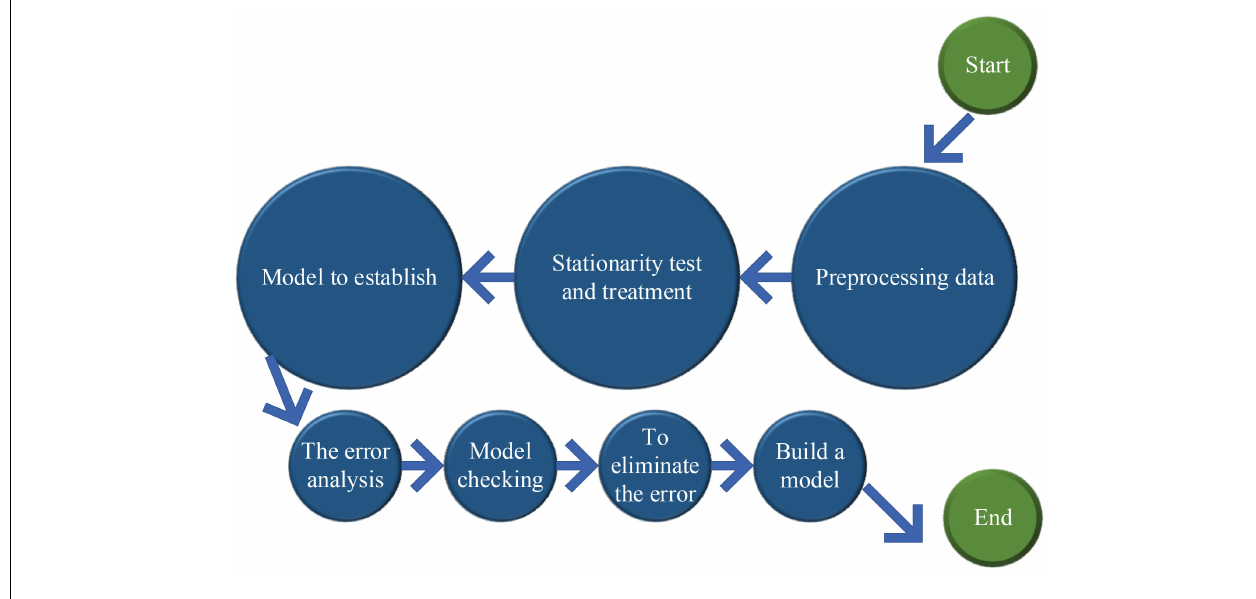
FIGURE 6 | Prediction steps of the SARIMA-BPNN model.